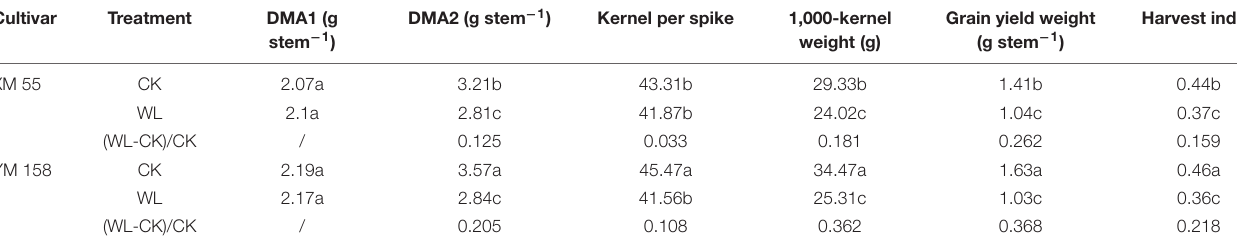
TABLE 1 | Effect of waterlogging on yield and yield components of wheat. Cultivar